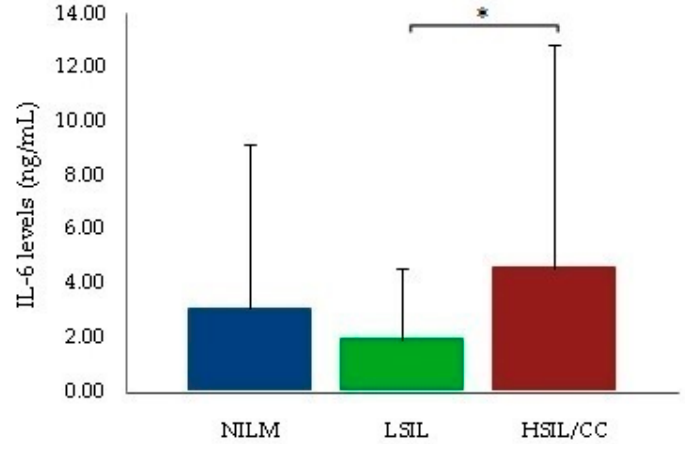
Figure 1. Comparison of mean IL-6 levels between women with LSIL and HSIL/CC. Note that IL-6 = interleukin-6.* 1.96 ± 2.62 versus 4.59 ± 8.27; p = 0.046.